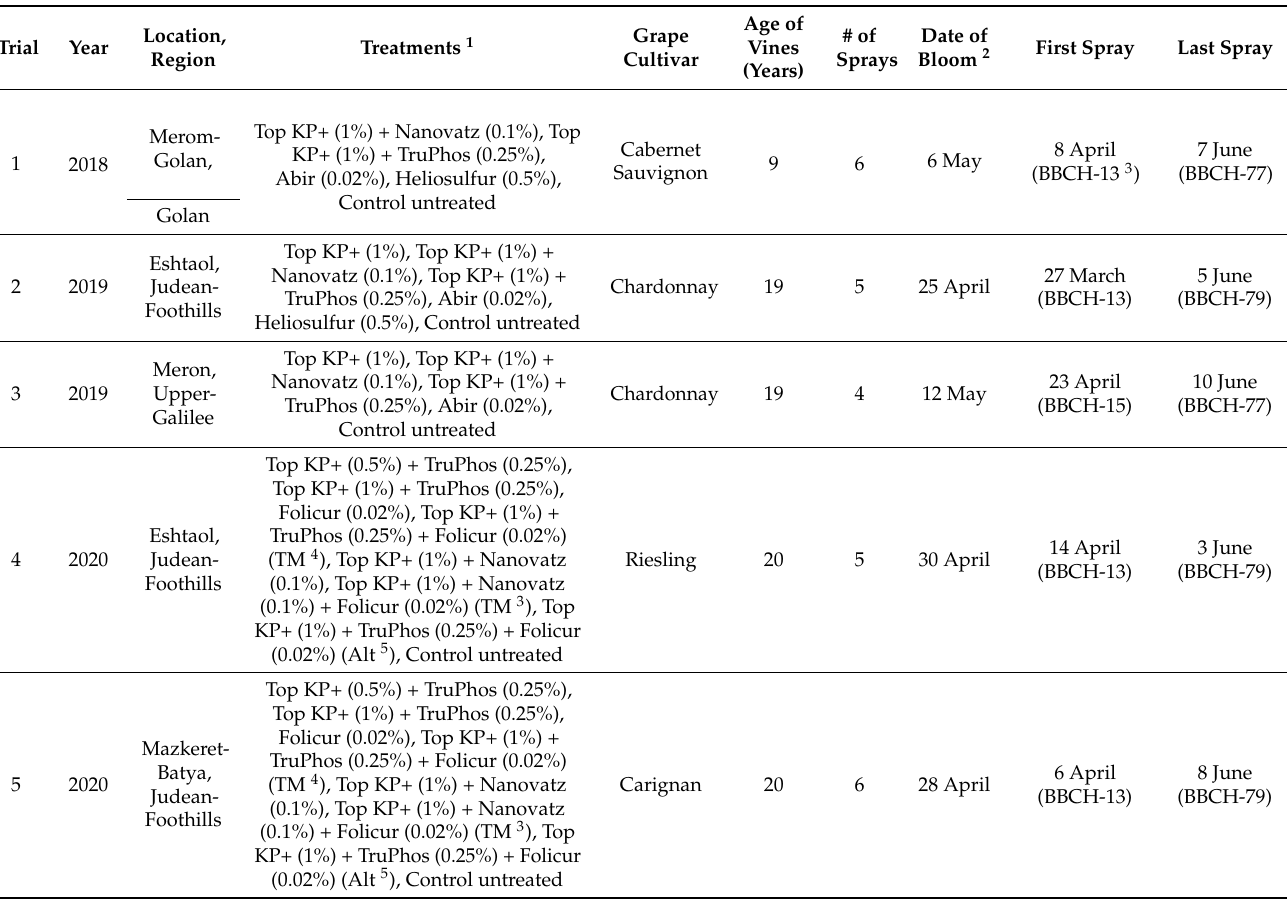
Table 6. Field trials conducted to assess the efficacy of nutrients and fungicides against E. necator